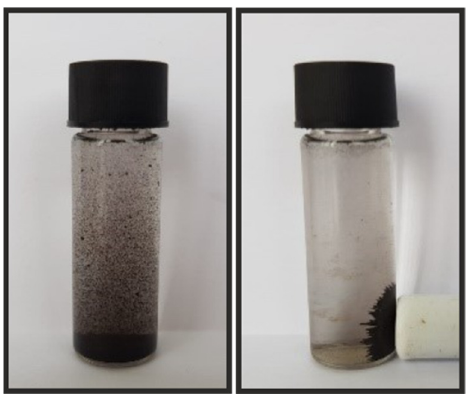
Figure 2. Recoverability of Fe 3 O 4 -CWH nanocatalyst with external magnet. Figure 7. Recoverability of Fe 3 O 4 -CWH nanocatalyst with external